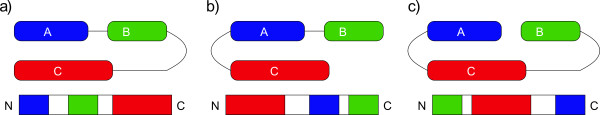
Circular permutation example. The cartoon illustration of three protein structures whose domains are similarly arranged in space but appear in different order in primary sequences. The location of domains A, B, C in primary sequences are shown in a layout below each structure. Their orderings are related by circular permutation [2].